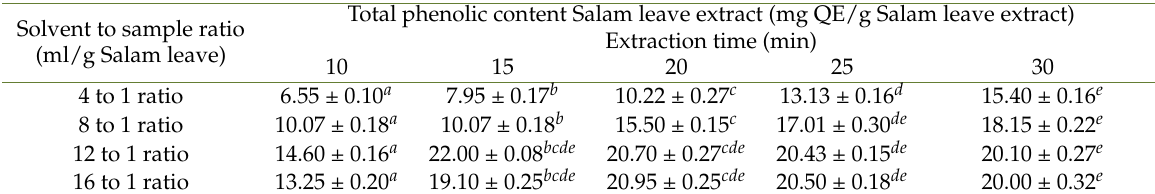
Table 3. Total flavonoid content of Salam leave extract Solvent to sample